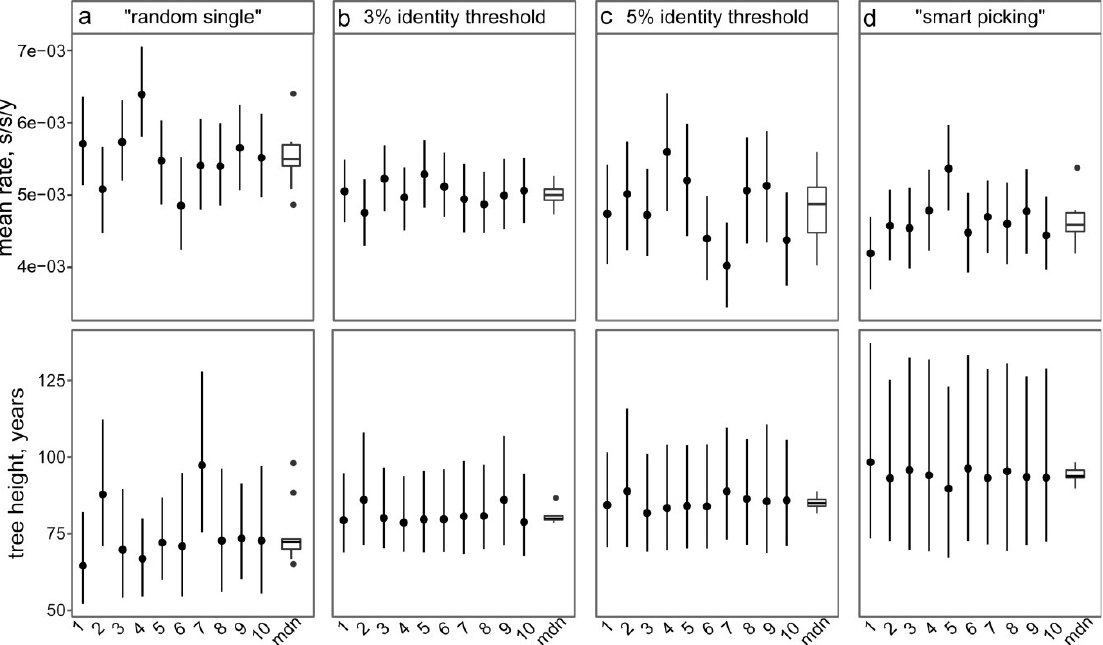
Figure 4. The effect of dataset preparation algorithm on the Bayesian inference of mean substitution rate and tree height. Ten alignments were created from a set of 6902 EV-A71 VP1 sequences using the following algorithms: picking 400 random sequences ( a ); identity filtration with 3% cut-off, resulting in 380 sequences ( b ); and 5% cut-off, resulting in 95 sequences ( c ); and a “smart picking” algorithm, resulting in 447 sequences ( d ). The median values and 95% HPD intervals of the mean substitution rate and tree heights for each of ten sampling replications are shown as dots and ticks, respectively. Boxplots show the median values (mdn) and outliers for each